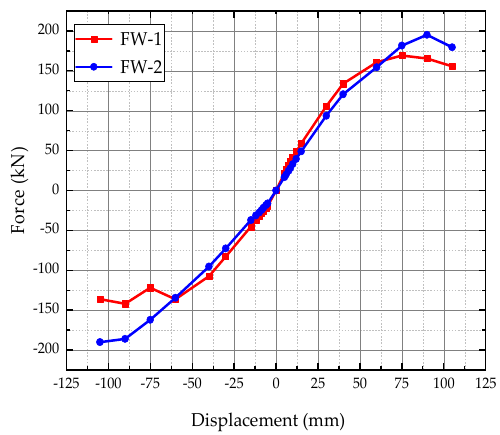
Figure 15. Skeleton curves of FW-1 and FW-2.